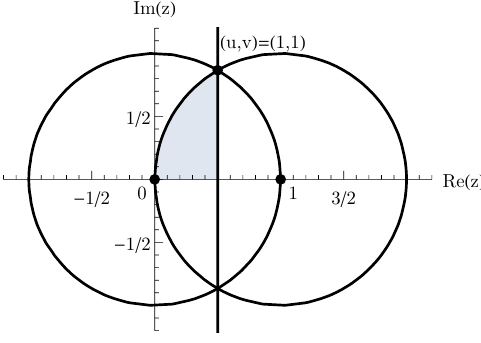
Figure 2 . The fundamental domain of integration de(cid:12)ned by the constraints of eq. (2.17). Crossing symmetry corresponds to re(cid:13)ections across the line at Re( z ) = 1 z = 0 and z =